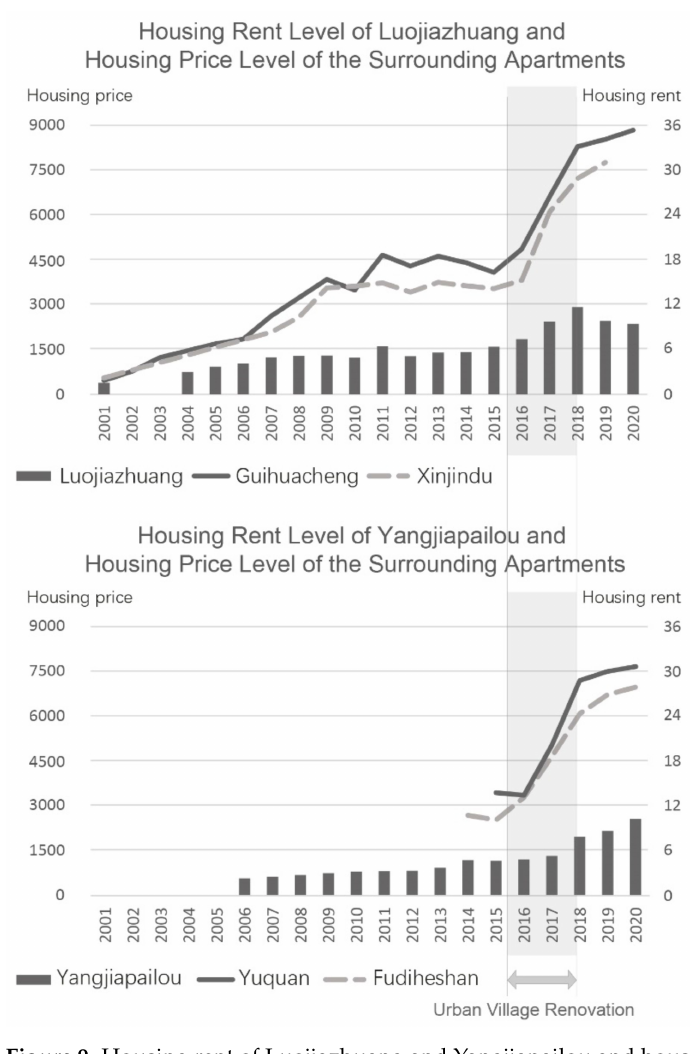
Figure 9. Housing rent of Luojiazhuang and Yangjiapailou and housing price of their surrounding commercial housing (Unit of rents: USD/m 2 /month; Unit of housing price: USD/m 2